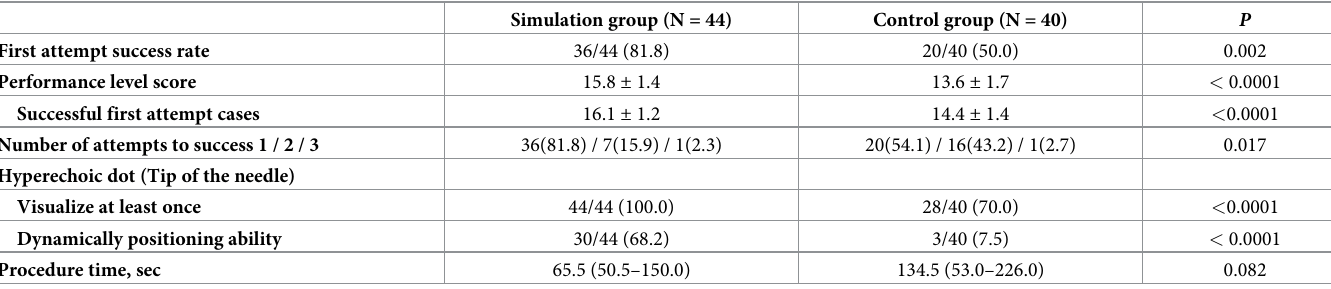
Table 3. Ultrasound-guided radial arterial cannulation performance data in real